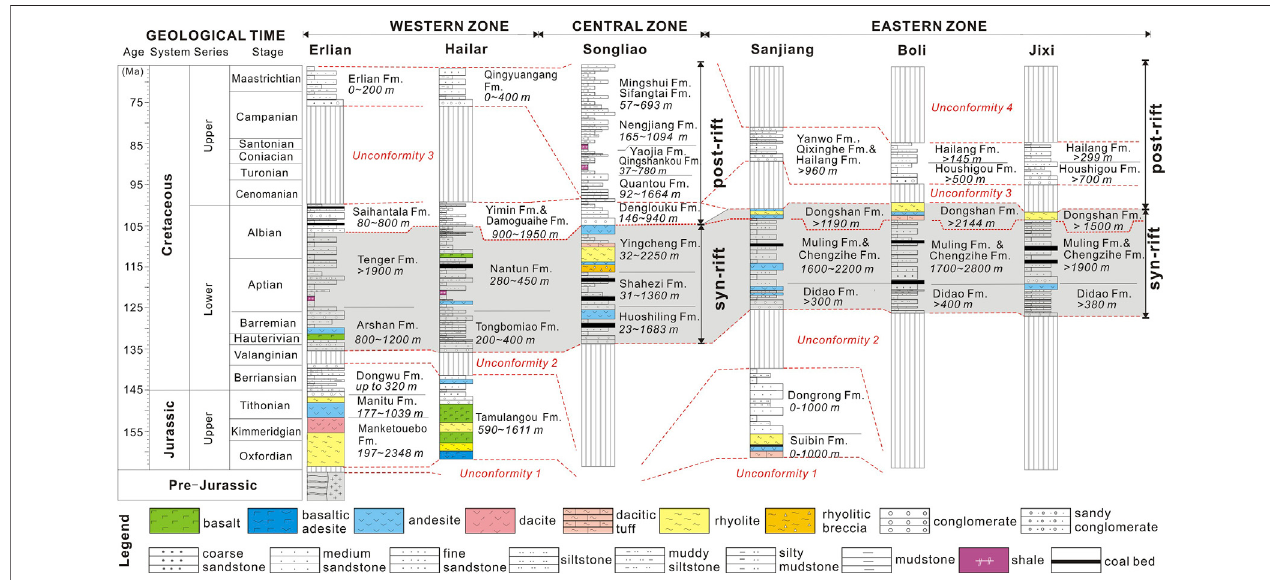
FIGURE 9 | Stratigraphy of seven representative late Mesozoic basins in NE China (Zhang et al., 2017b).